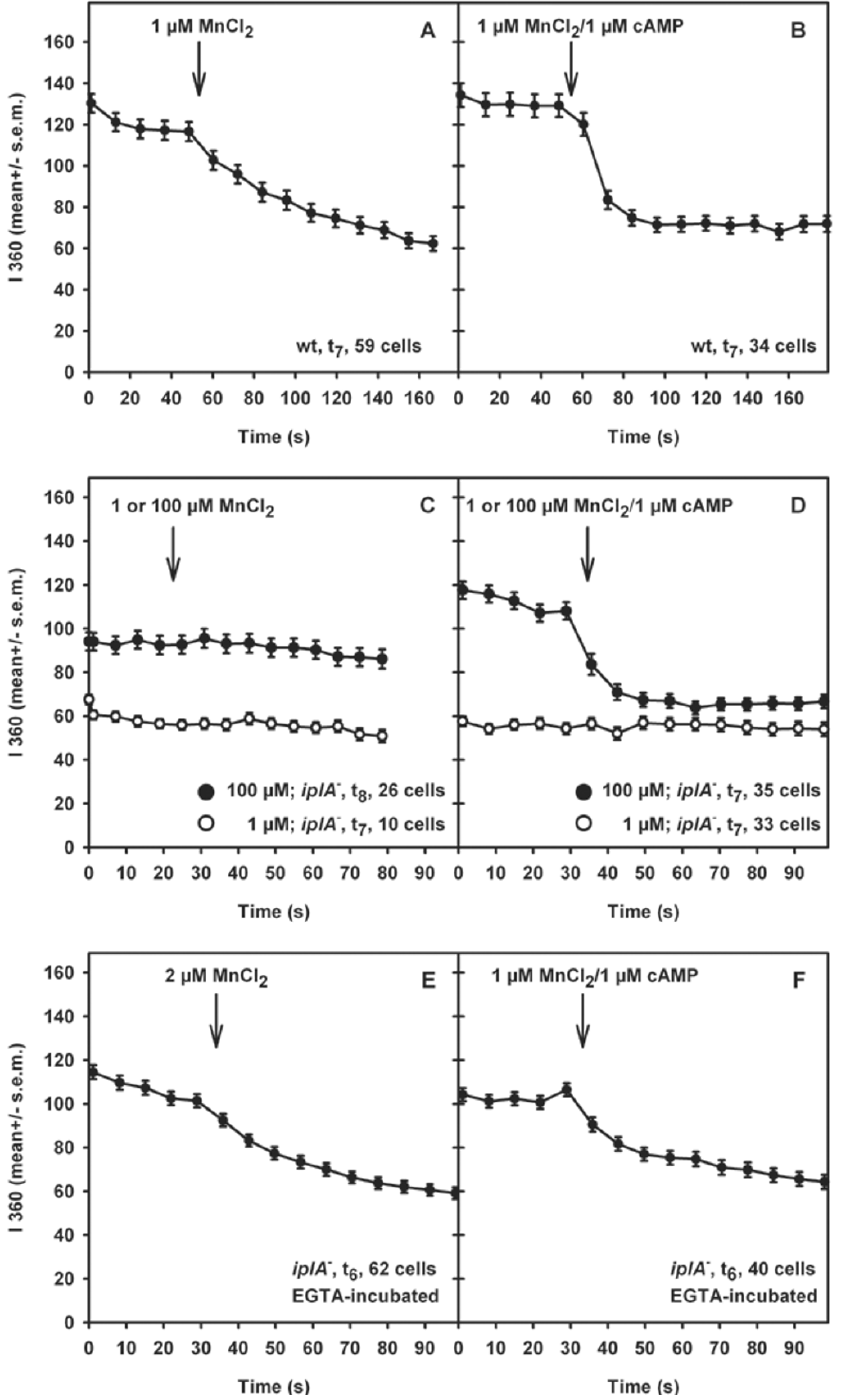
Figure 11 Basal and cAMP-induced Mn 2+ -influx. Influx was assayed by quenching of Fura2-dextran fluorescence. (A, B) The response of wild type amoebae is shown for comparison; 1 µ M Mn 2+ ± 1 µ M cAMP was added. iplA - cells in nominally Ca 2+ -free buffer were challenged with 100 µ M Mn 2+ ± 1 µ M cAMP at t (closed symbols); when 1 µ M Mn 2+ was added (open symbols) no influx was 7 detected (C, D). After preincubation with EGTA influx was observed at 1–2 µ M Mn 2+ ± 1 µ M cAMP (E, F). Fluorescence inten- sity at 360 nm excitation is shown as mean ±